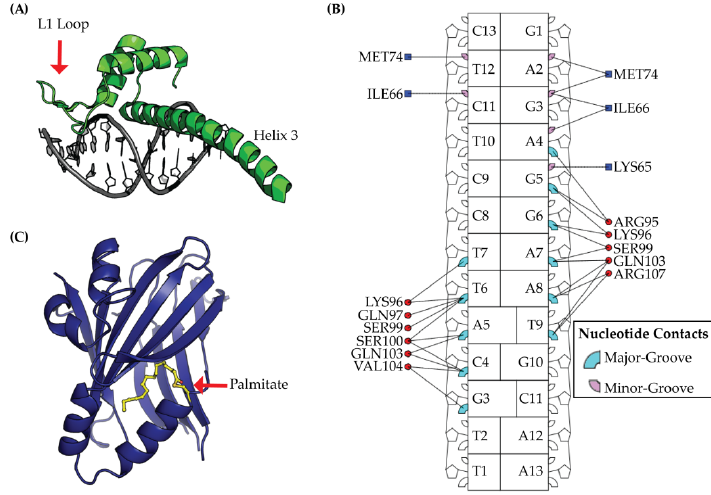
Figure 3. TEAD is a protein with multiple domains, which is composed of a DNA Binding Domain (DBD) and a YAP Binding Domain (YBD). ( A ) The DBD structure is illustrated from protein data bank ID (PDB) 5GZB and is composed of a homeodomain fold with three alpha helices (shown in green) bound to DNA (colored in grey); ( B ) Structural analysis of TEAD DBD using the interaction map from DNAproDB [34] illustrates the DNA major- and minor-groove protein residue contacts in cyan and pink, respectively. Nucleic acid contacts with DBD L1 loop are indicated by a blue square and contacts with DBD helix 3 are shown as red circles; ( C ) The YBD is post-translationally modified by palmitate (colored yellow) that extends towards the interior of YBD (colored in blue).